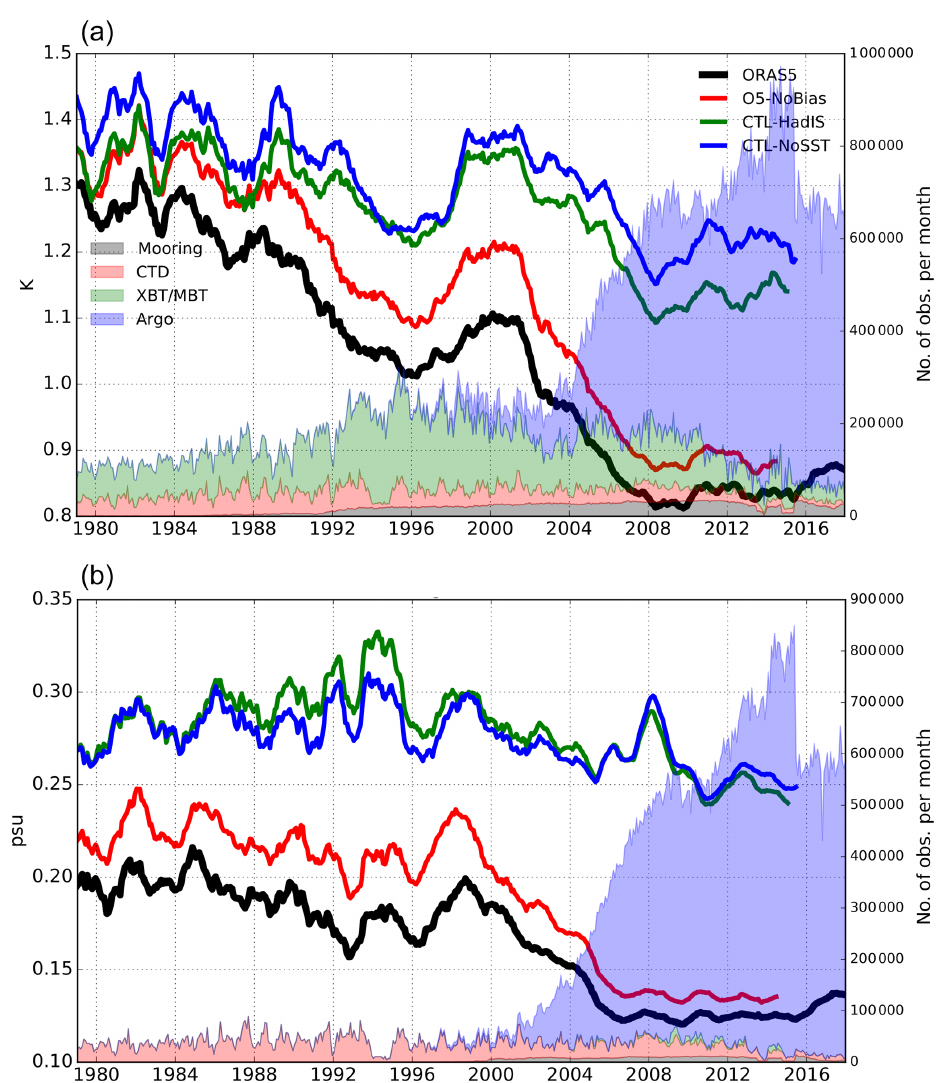
Figure 16. Time series of global mean model fit-to-observation RMSE in (a) temperature (K) and (b) salinity (psu) from ORAS5 (black), O5-NoBias (red), CTL-HadIS (green) and CTL-NoSST (blue). Diagnostics are computed using model background departures from EN4 in situ observations before June 2015, and departures from GTS observations from June 2015 on, and averaged over the upper 1000m after being smoothed with a 12-month running mean filter. Coloured patches and right y axes show number of observations from different sources assimilated per month in ORAS5, accumulated for the upper